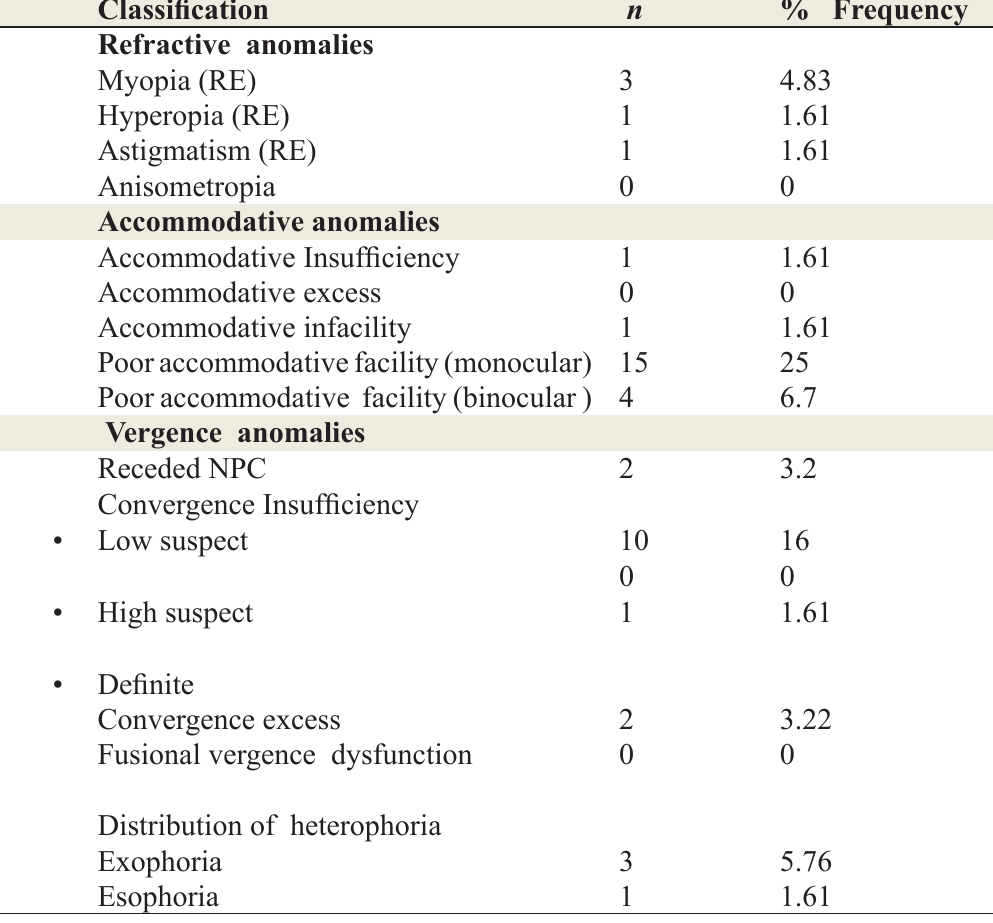
Table 2: Prevalence of outcome variables